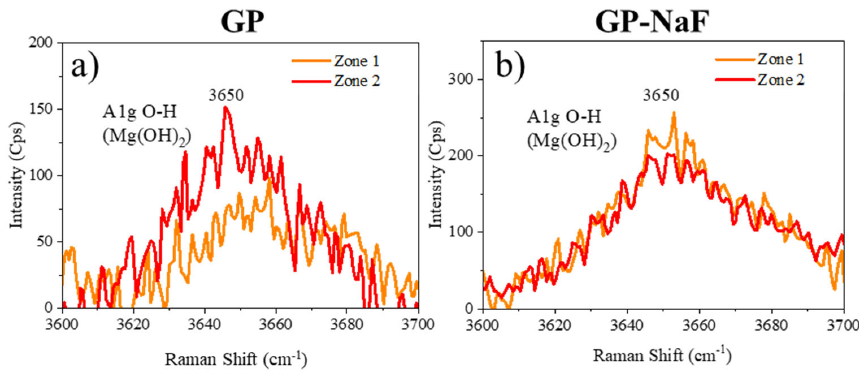
Figure 3. Raman spectra of 2 zones of the corrosion product (CP) layers of samples ( a ) GP and ( b ) GP ‐ NaF.